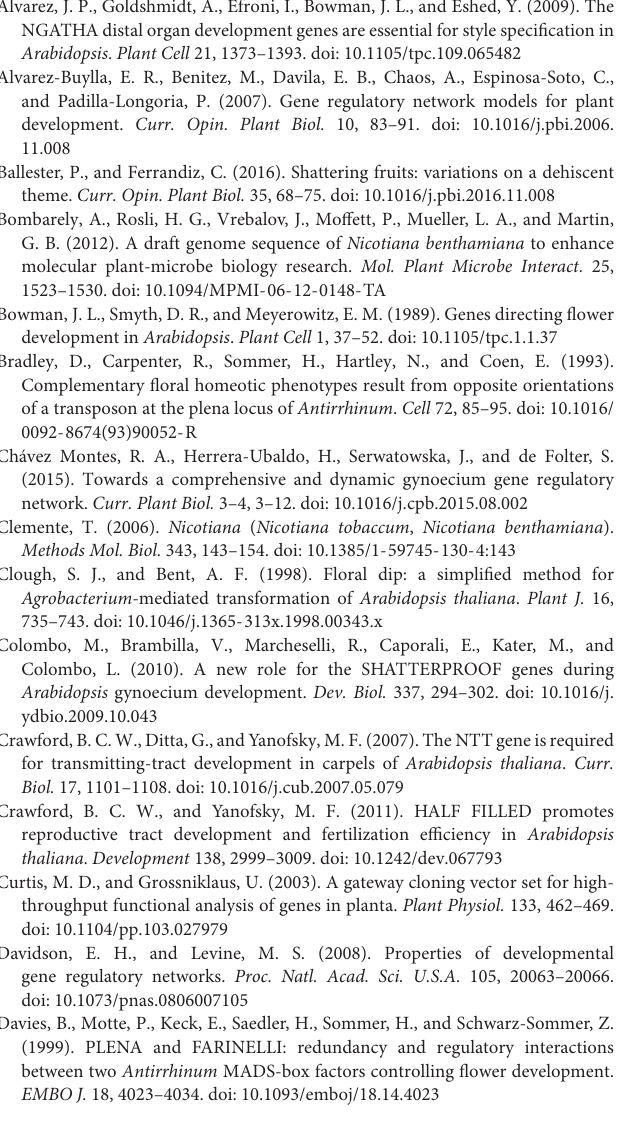
FIGURE S3 | Fruits of transgenic Arabidopsis plants transformed with the 35S::EsSRS-L construct in wildtype (left) or sty1 sty2 (right) backgrounds. FIGURE S4 | Expression level by real-time PCR analysis of NbSRS-L1 (orange bars), NbSRS-L2 (pink bars) and NbSRS-L3 (blue bars) in